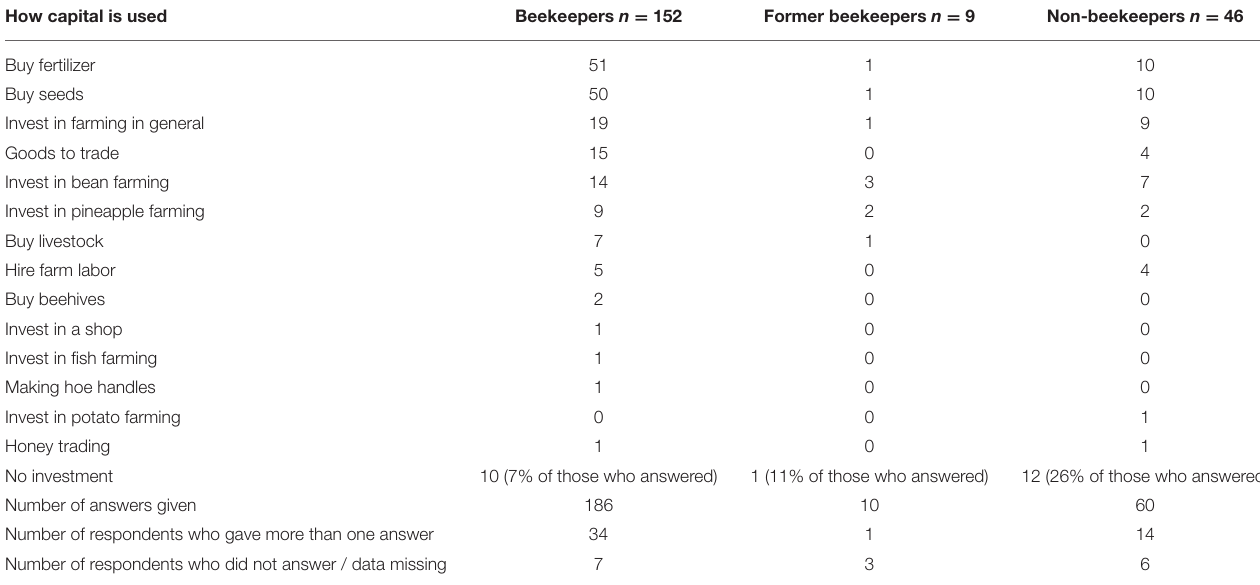
TABLE 9 | Responses about investment of capital from all respondents. How capital is